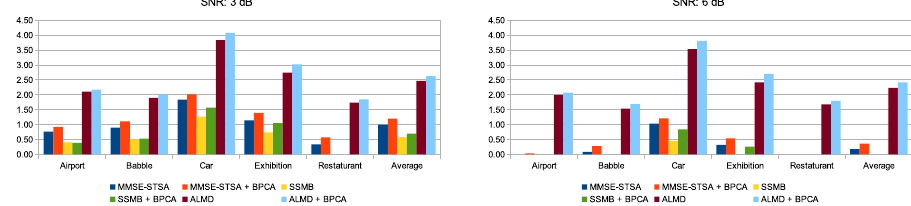
Figure 10. SSNR improvement in dB with regard to the noise floor scores for all noise types and SNR noise levels. (For interpretation of the bar colors, the reader is referred to the web version of this article).